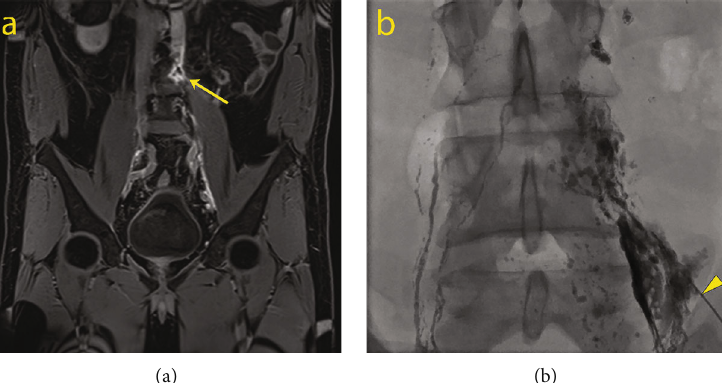
Figure 3: Magnetic resonance lymphangiogram with Lipiodol. Dynamic contrast-enhanced magnetic resonance lymphangiogram (a) with maximum intensity projection and the subtraction of noncontrasted structures shows a leak site at the L4-L5 level (arrow). (b) Shows the percutaneous embolization with Histoacryl® (head arrow) after identifying the leakage point in the lymphography with Lipiodol.